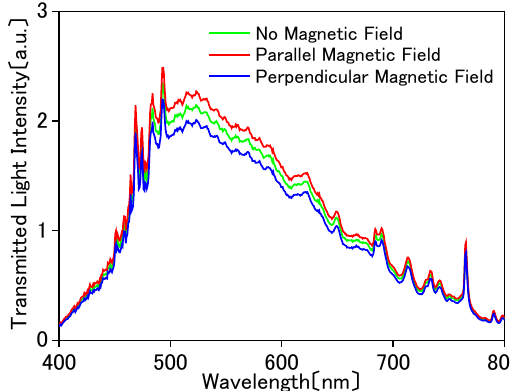
Figure 11. Transmitted light intensity of the suspension of nickel coated hemispherical Janus particles. The transmitted light intensity was increased by 1.1 times with the magnetic field applied parallel to the light propagation direction, compared with the case of the perpendicular field. This is because the chain of self-assembled particles is aligned parallel to the light direction with the parallel magnetic field for the cross section in the light direction is minimized, while it intersects the light direction with the perpendicular field for the cross section is maximized.